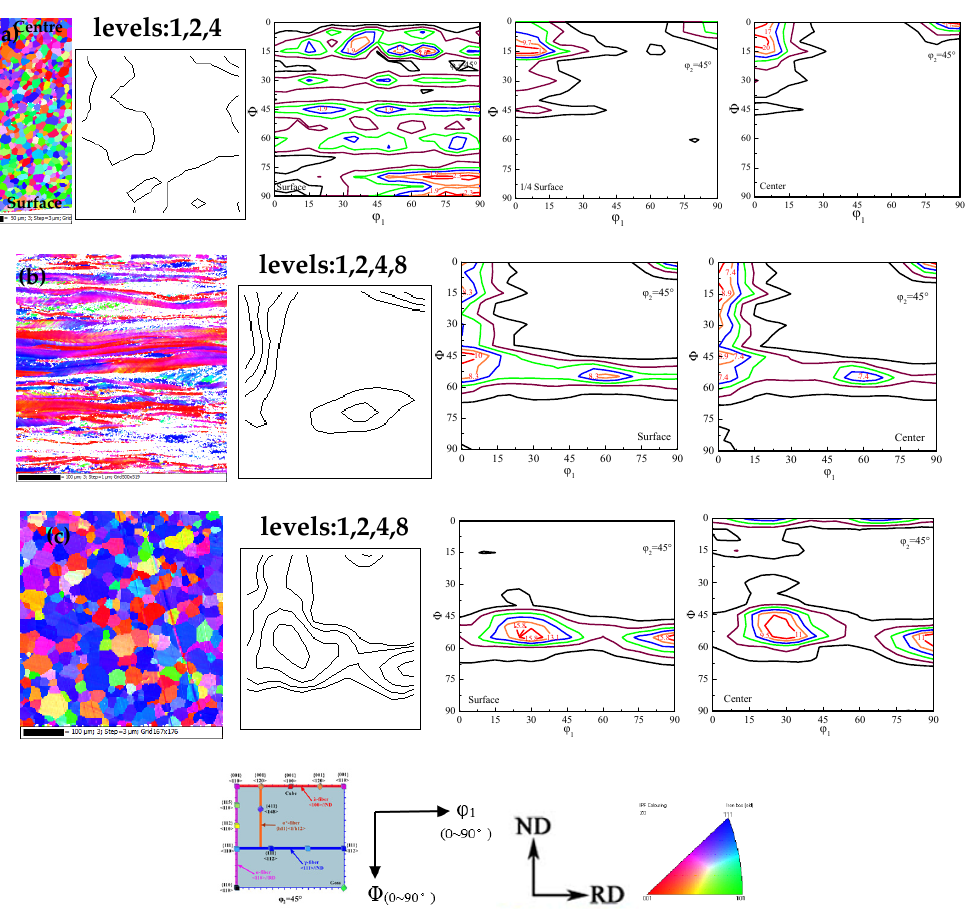
Figure 2. EBSD inverse pole figure (IPF) maps, micro-texture and macro-texture at different thickness layers in the ϕ 2 = 45 ◦ of Fe-0.65%Si hot-rolled band ( a ), cold-rolled sheet ( b ) and annealed sheet ( c